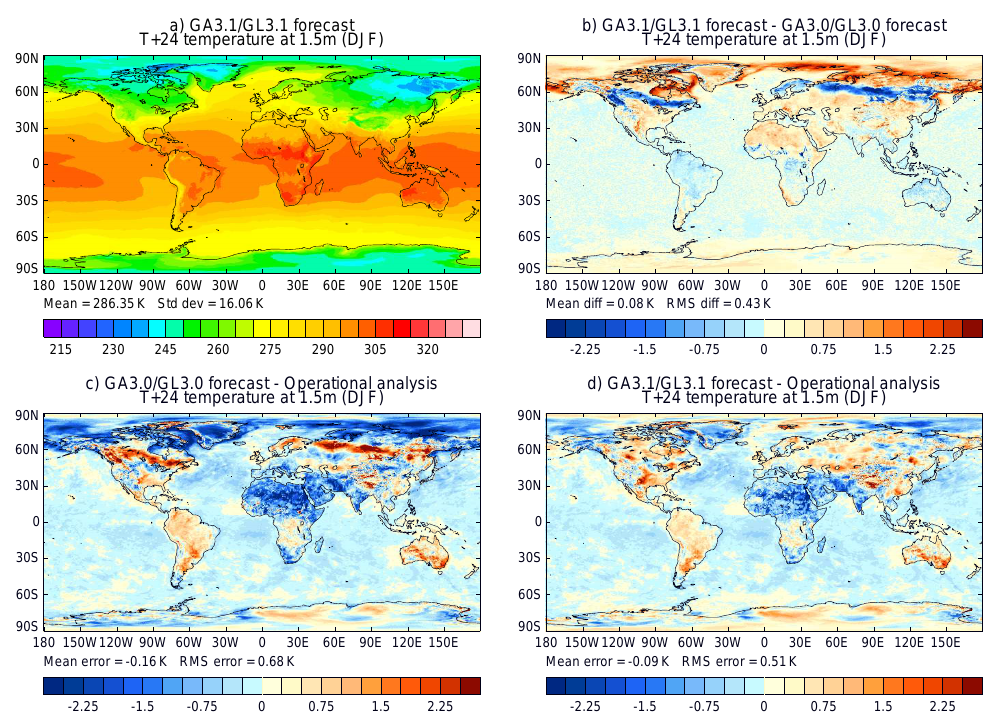
Fig. 10. Mean 24 hour forecast 1.5 m temperatures from the 10 N320 NWP case studies in DJF using Fig. 10. Mean 24h forecast 1.5m temperatures from the 10 N320 NWP case studies in DJF using the same format as Fig. 8. the same format as Fig. 8.